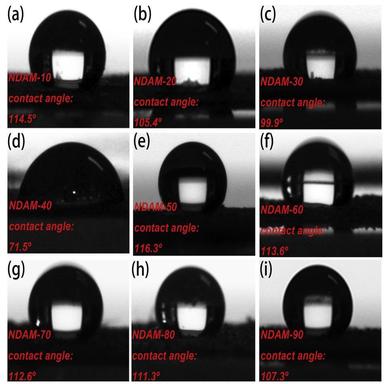
Contact angles of a series of NDAMs.